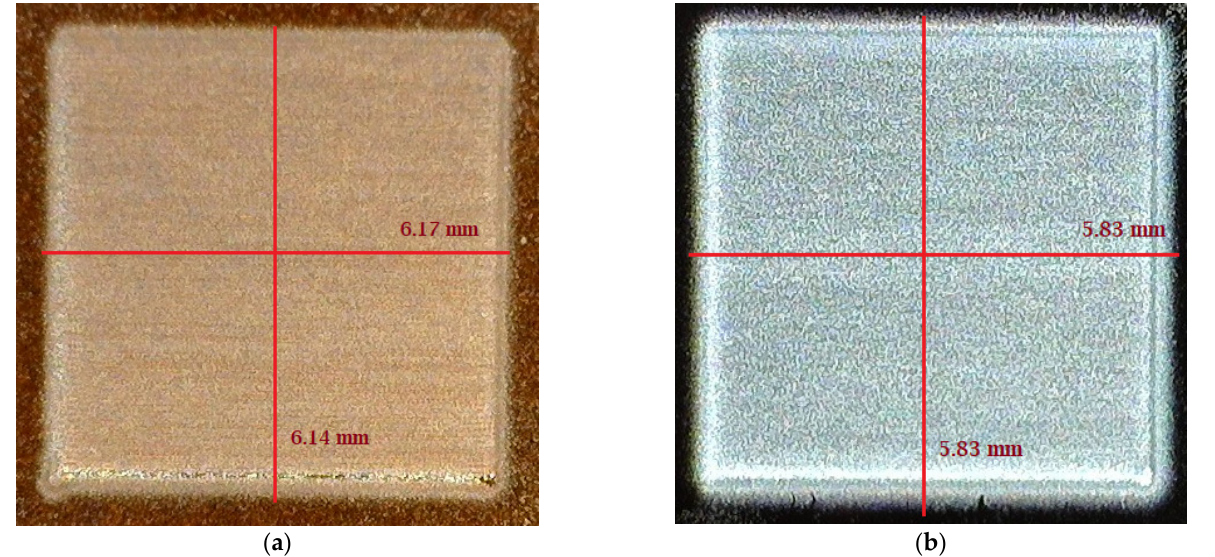
Figure 6. 2.5% PVA printed on Kapton and Silicon. ( a ) 5 mm × 5 mm targeted pattern printed on Kapton; ( b ) 5 mm × 5 mm targeted pattern printed on Silicon.